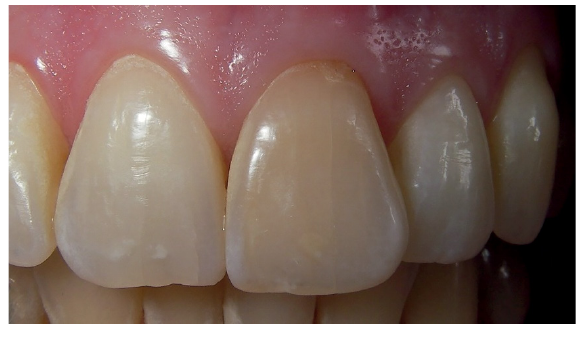
Figure 4. Crown discoloration to a yellowish hue in tooth 21. This is a common finding in teeth with PCO, and is caused by the excessive deposition of dentin, which may affect the light-transmitting properties of the tooth, resulting in a gradual opacity of the crown. TDI was classified as a concussion.